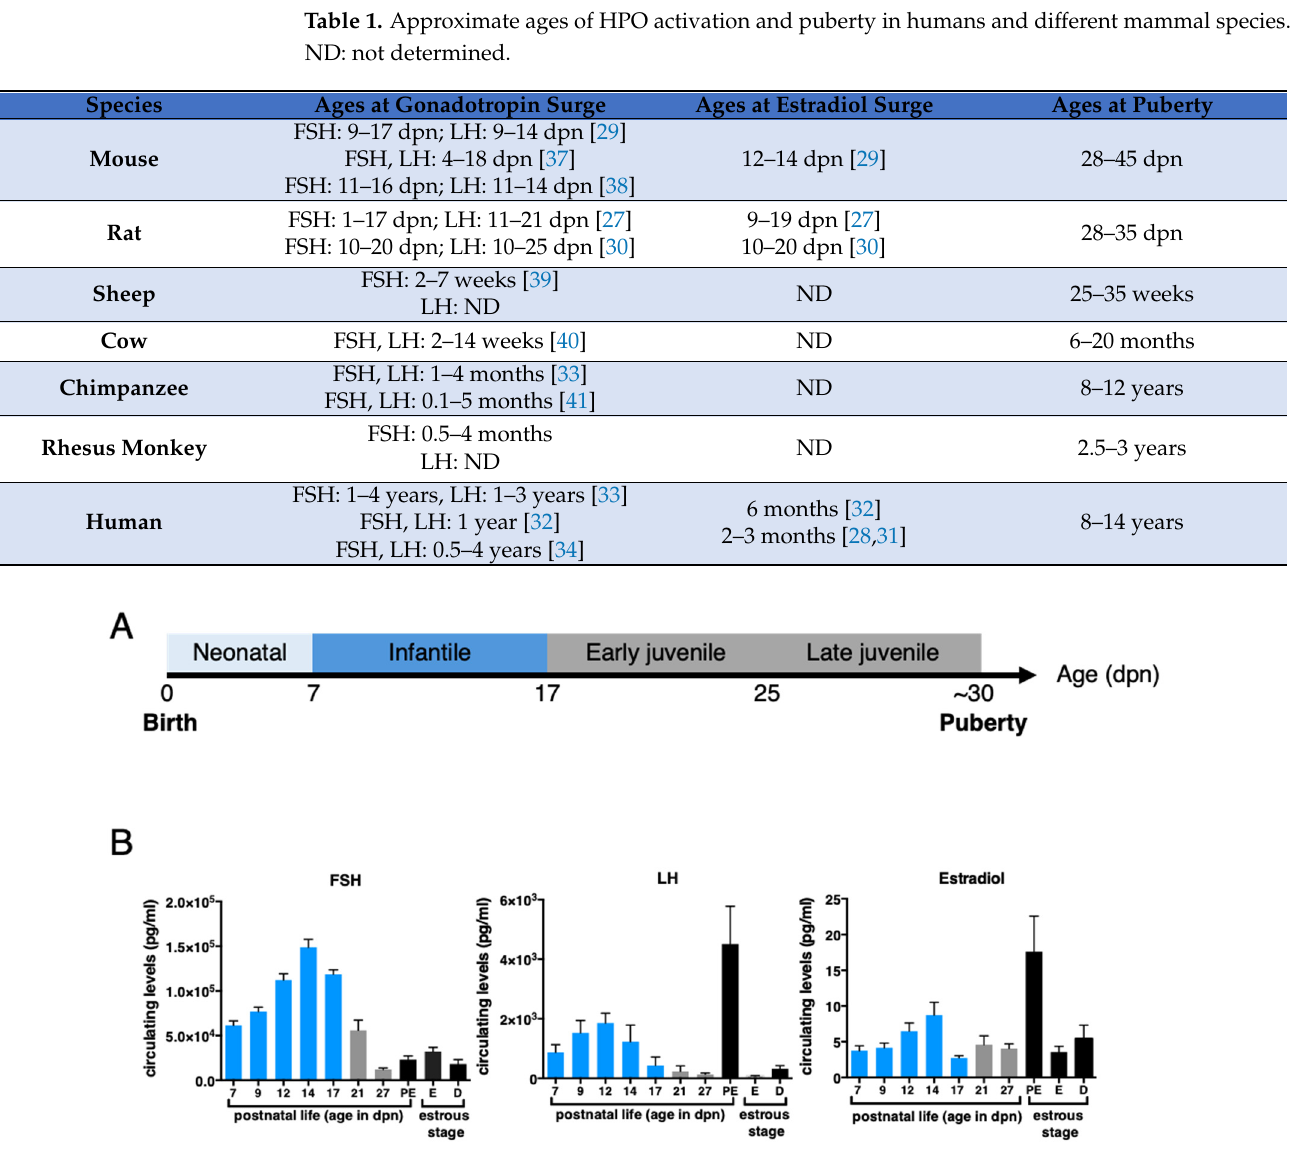
Figure 2. Significant changes in reproductive hormone levels during prepubertal life in the mouse. ( A ) The different stages of the prepubertal period in the mouse. The chronological axis displays the neonatal, infantile, and juvenile periods in this species. Mini-puberty takes place within the infantile period. ( B ) Gonadotropin and estradiol levels in prepubertal and adult female mice at different stages of the estrous cycle were determined by Luminex assay and GC/MS-MS, respectively, as pub- lished by our group in [29], including the additional age of 27 dpn analyzed at the same time as the other ages using the same methods. Hormonal levels of the infantile period are shown as blue bars.